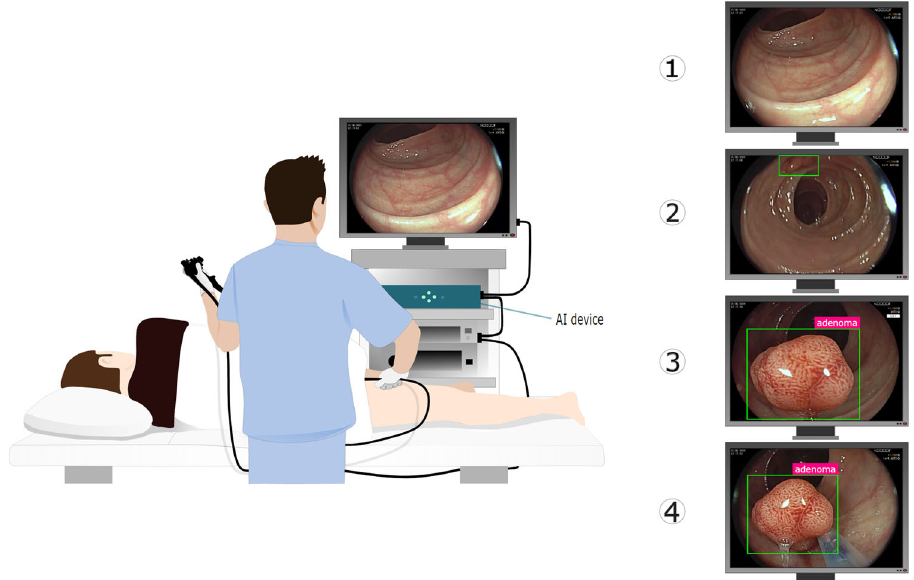
Fig. 1 AI device intended use work fl ow. The endoscopy video stream fl ows through the device with no modi fi cation or delay (<1.5 μ s). In real time (50 – 60 ms), the device augments the video stream by adding overlay markers to surround areas of interest, such that they can be further inspected by the endoscopist. During colon navigation (1), the endoscopist is focused on exposing the mucosa appropriately in order to facilitate the task of polyp detection. The AI intelligent device activates when a polyp is detected (2, CADe). At this stage, the endoscopist examines the mucosa in order to characterize the lesion and decide on clinical action: if a polyp is framed consistently by the endoscopist, the CADx activates automatically (3) and the histology prediction is added to the green box. After possible endoscopic resection of the polyp (4), navigation is resumed (1) and CADx automatically disengages. These tasks are iterated as a loop until the end of the procedure. Table 1. Experts, non-experts, and CADx performance metrics for optical characterization.